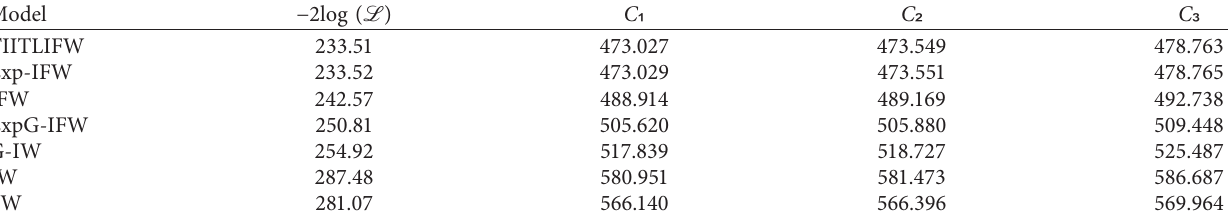
Table 6: Statistics for lifetimes data.